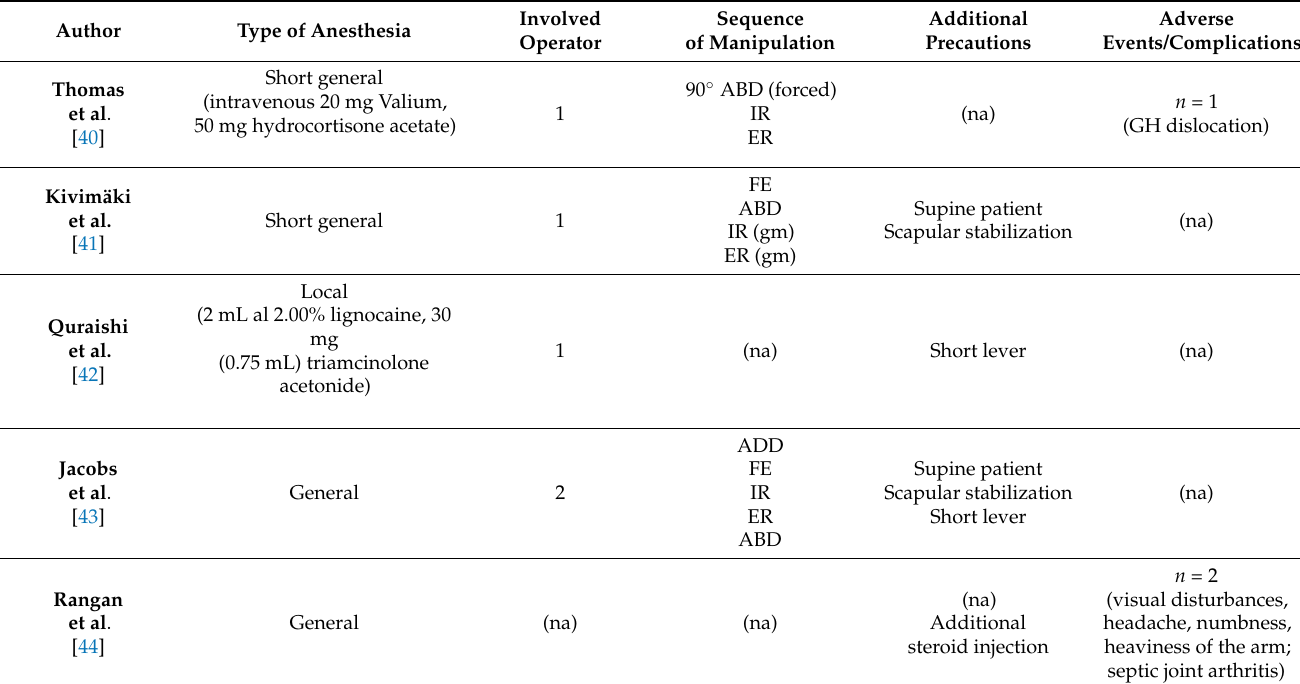
Table 3. Characteristics of MUA procedures and reported adverse